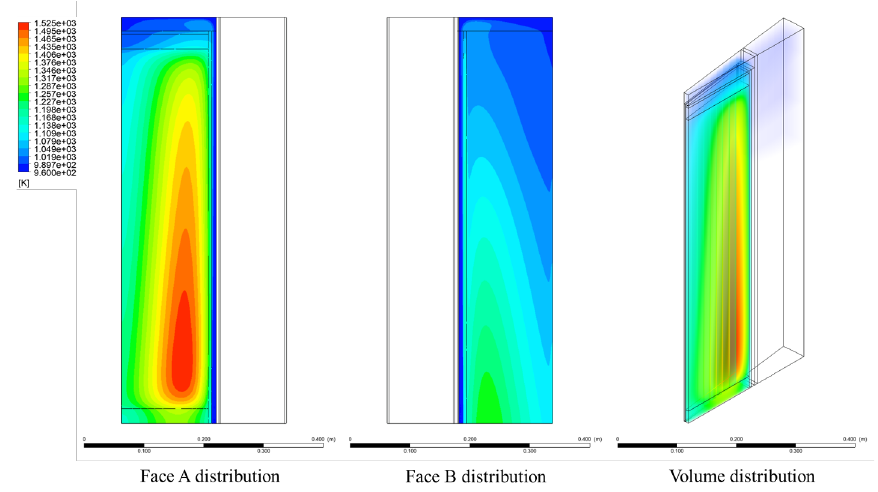
Figure 5. Temperature distributions of IGCR-200 reactor in normal operation